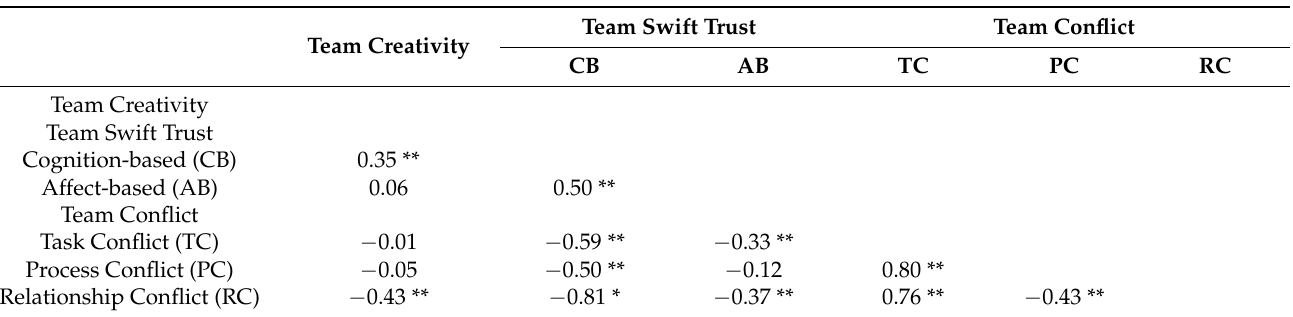
Table 2. Pearson’s correlations of student teams’ ( N = 54) scores on the team swift trust, team conflict, and team creativity